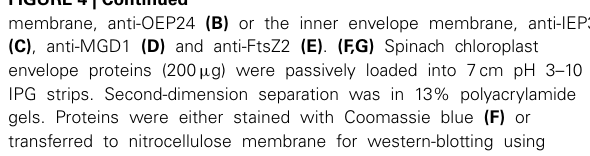
FIGURE 4 | Continued membrane, anti-OEP24 (B) or the inner envelope membrane, anti-IEP37 (C) , anti-MGD1 (D) and anti-FtsZ2 (E) . (F,G) Spinach chloroplast envelope proteins (200 µ g) were passively loaded into 7cm pH 3–10 IPG strips. Second-dimension separation was in 13% polyacrylamide gels. Proteins were either stained with Coomassie blue (F) or transferred to nitrocellulose membrane for western-blotting using